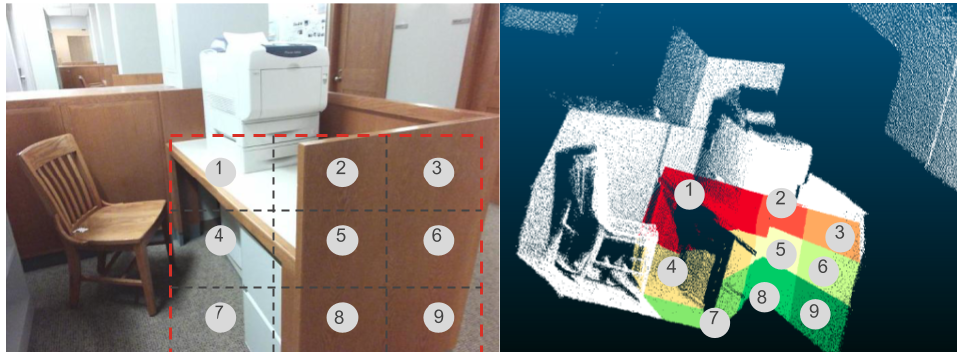
Figure 3. An example of equally subdividing a whole frustum into 3 × 3 subfrustums (best viewed in color). In this example, the object is a desk. The upper one shows the 2D bounding box of desk is equally divided into 9 small boxes. From each small box, a subfrustum is generated as shown in the bottom